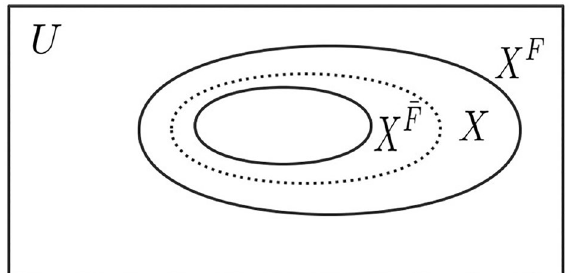
F F and X constitute